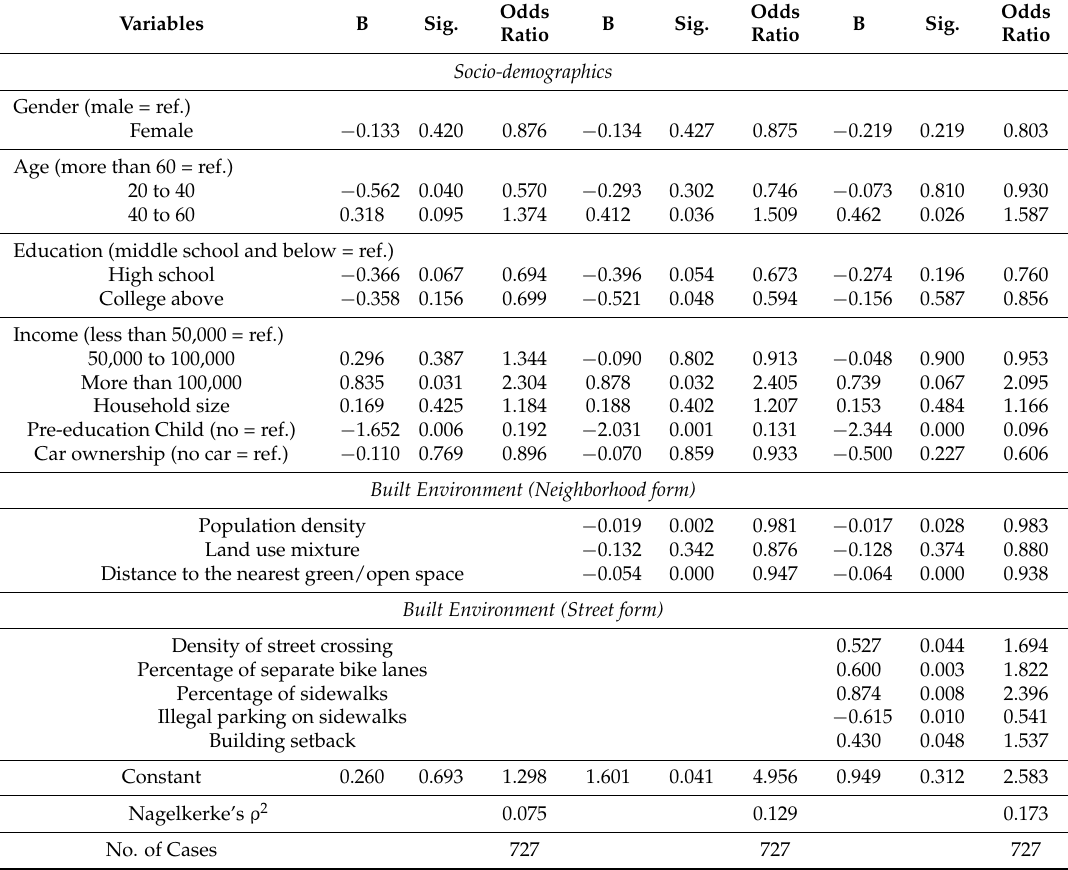
Table 6. Binary logistic model for discretionary